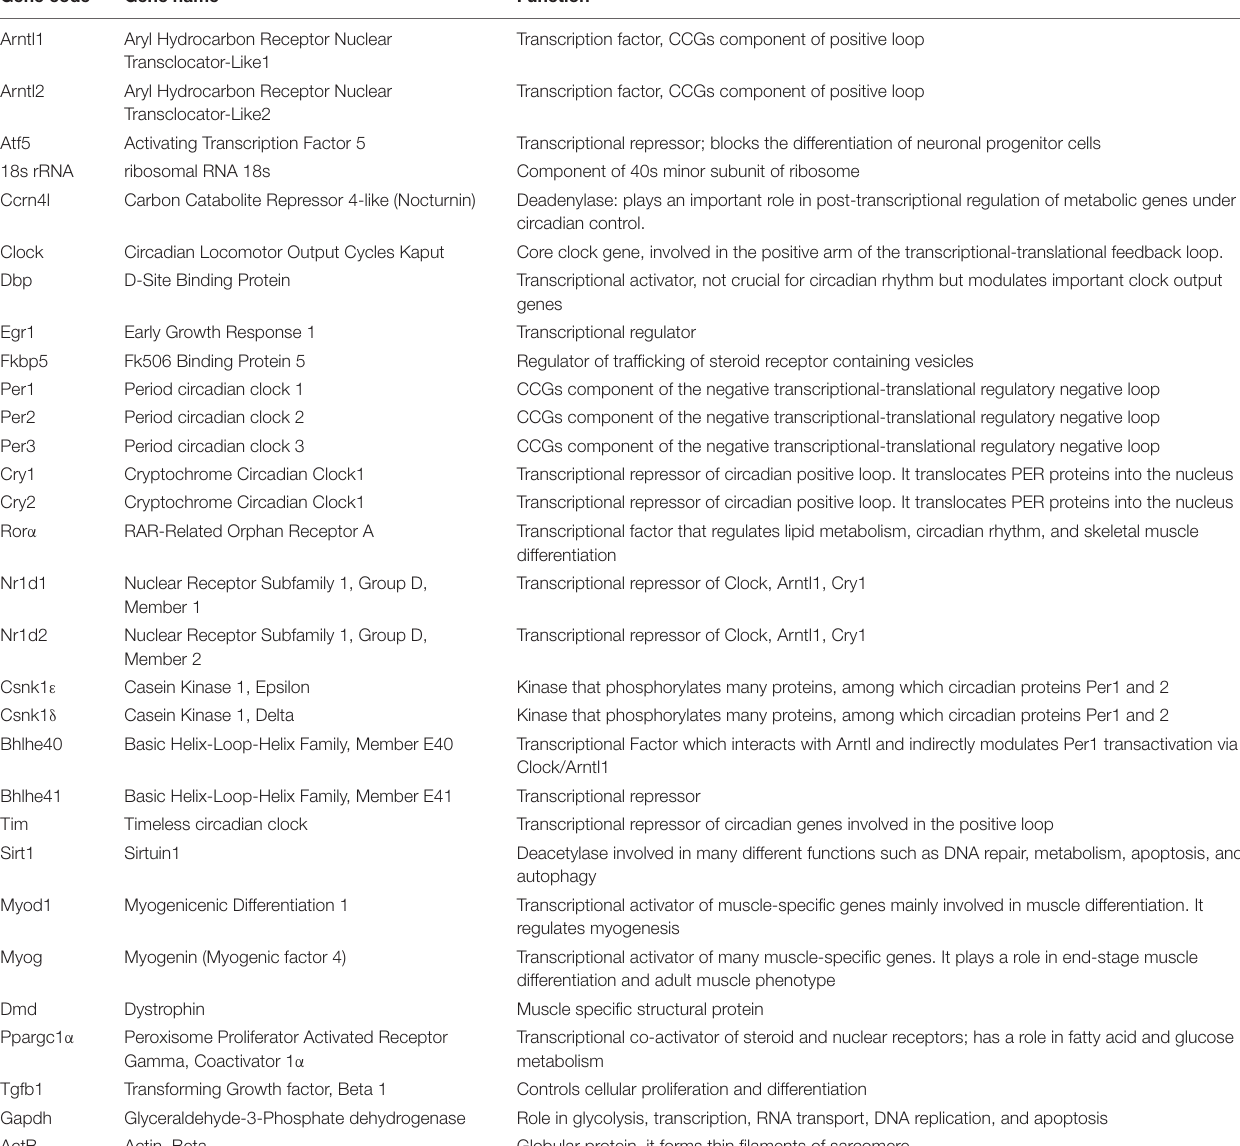
TABLE 2 | Selected genes for Fluid-CIRC